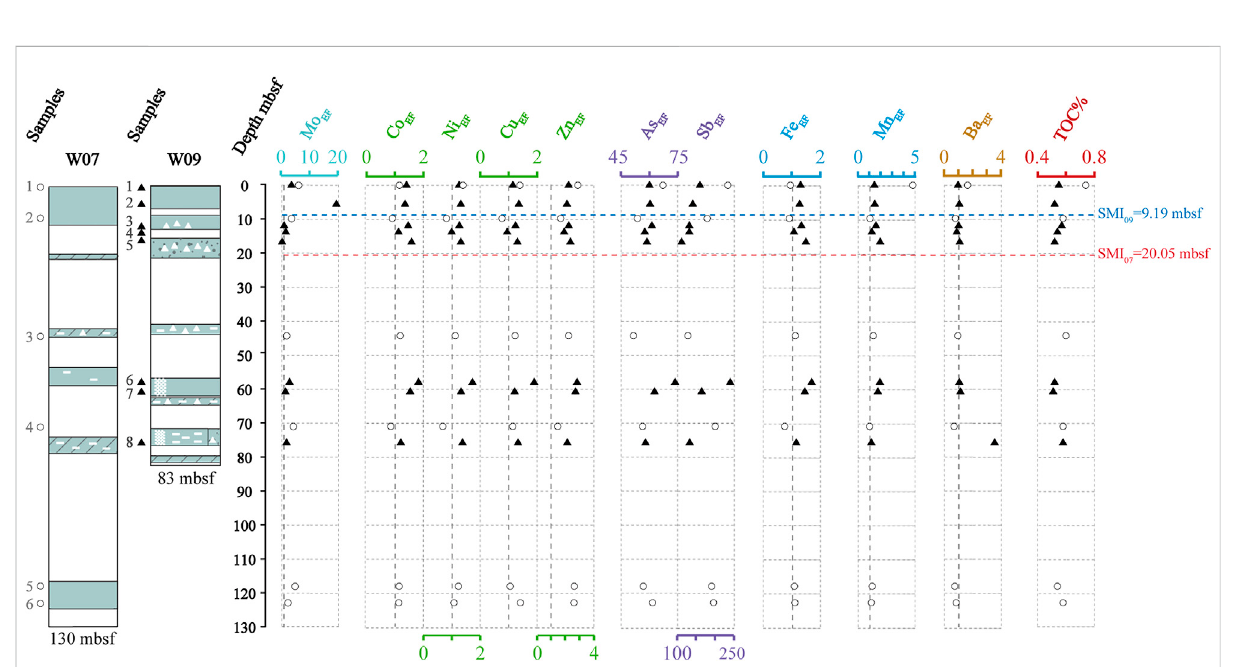
FIGURE 7 TOC%and enrichmentfactors ofMo(Mo EF ),Co (Co EF ),Ni (Ni EF ),Cu(Cu EF ),Zn(Zn EF ),As (As EF ),Sb(Sb EF ),Fe(Fe EF ),Mn (Mn EF ),and Ba(Ba EF )inthe sediment pro fi le at site W07 and site W09. The enrichment factor (EF) was calculated as X EF = [(X/Al) sample /(X/Al) average ], and the samples were normalized using Earth ’ s upper crust compositions (McLennan,